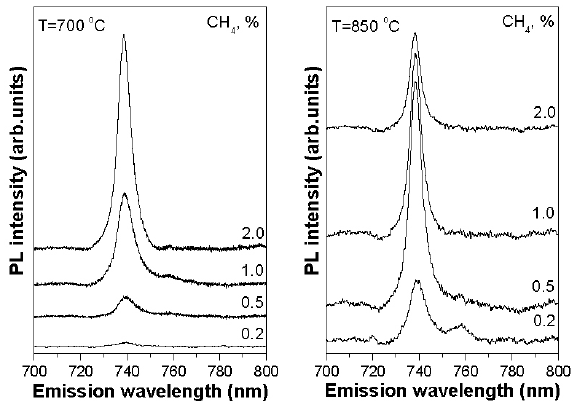
Figure 4: SiV peak region in the photoluminescence spectra of